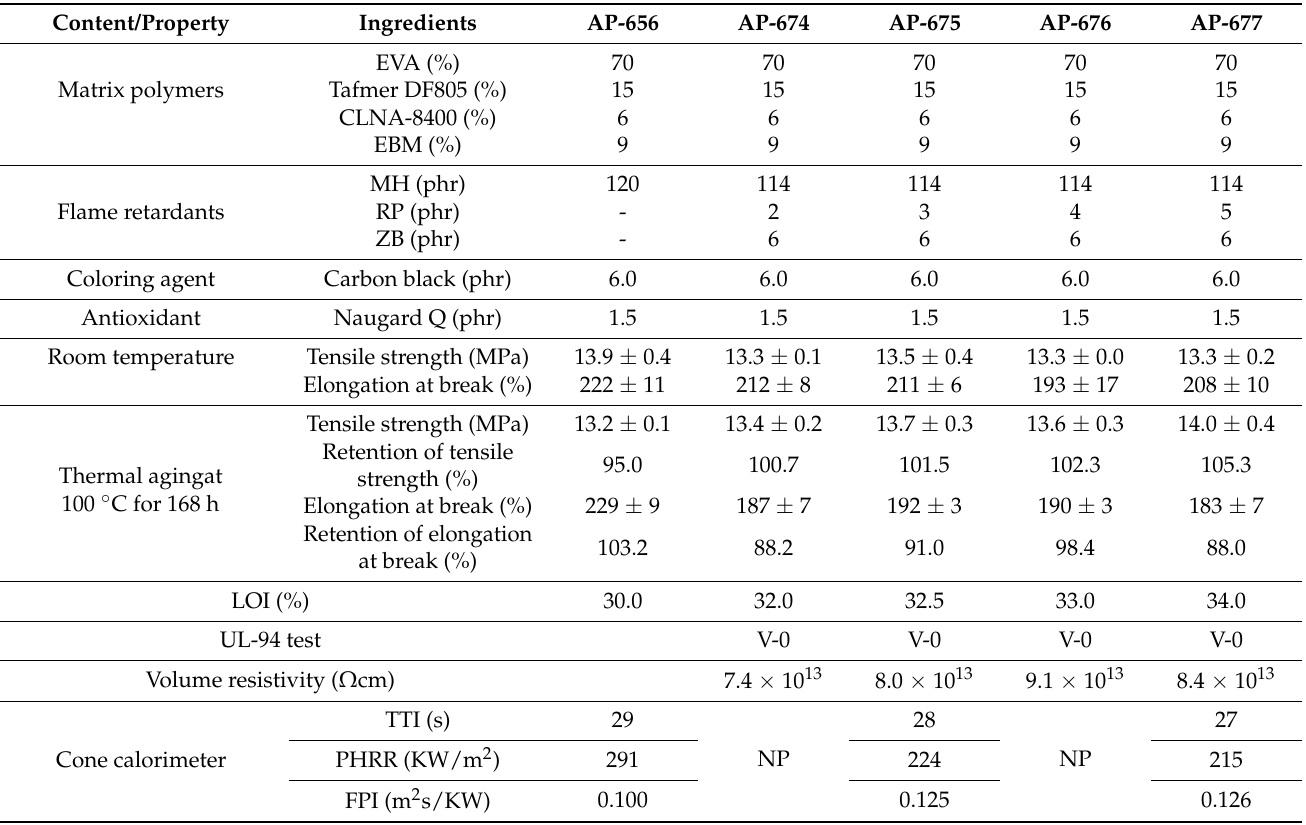
Table 3. EVA/Tafmer DF805/CLNA-8400/EBM/120 phr flame-retardant (MH+ZB) formulations as a function of additional RB